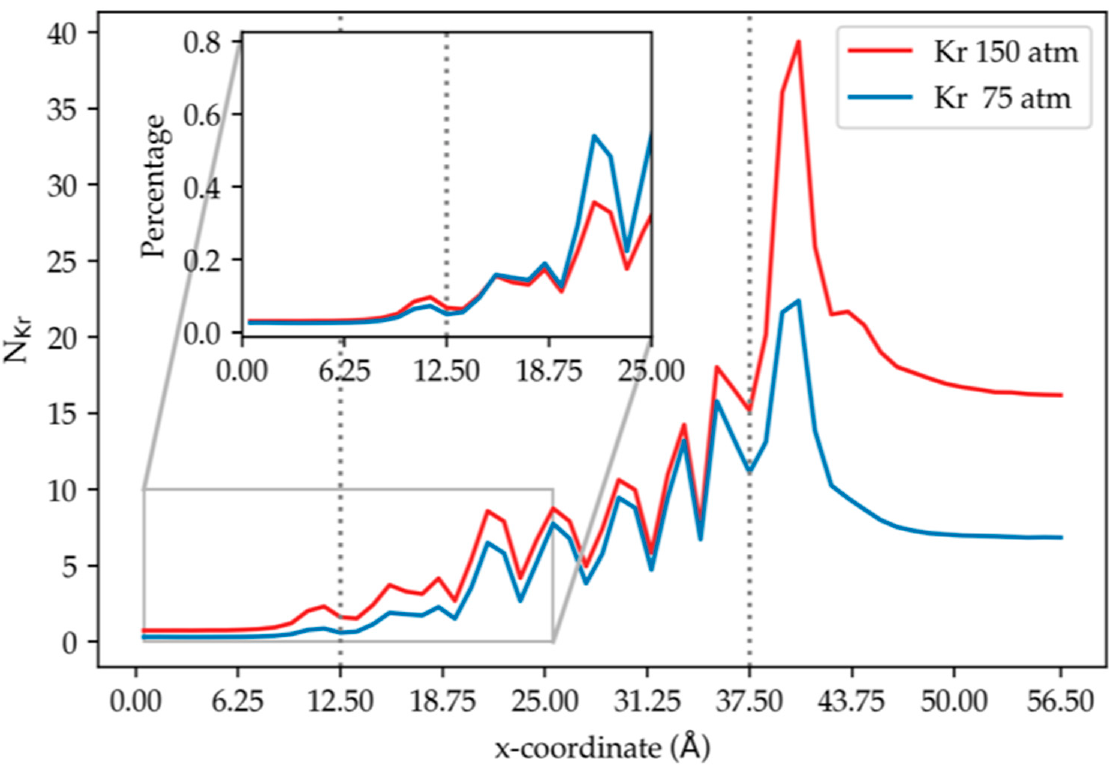
Figure 4. Density profiles of krypton along the direction normal to membrane surface (bin width = 1 Å). Ni = running average of the number of Kr atoms in the ith bin using results from simulation (1) and (2) at 300 K. The dashed vertical lines correspond to the membrane edges. For this and succeeding figures, the profiles in only one of the membranes in the simulation box are shown, since the other is related by symmetry.